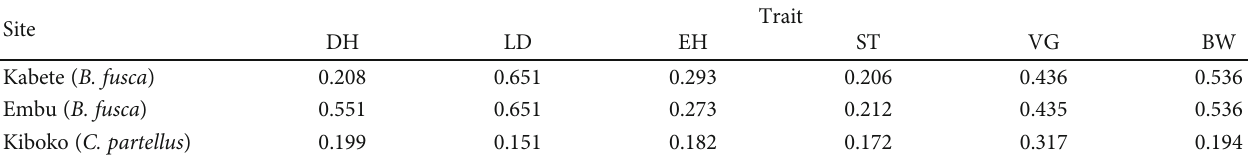
Table 5: Heritability estimates for stem borer damage and morphological traits at the three